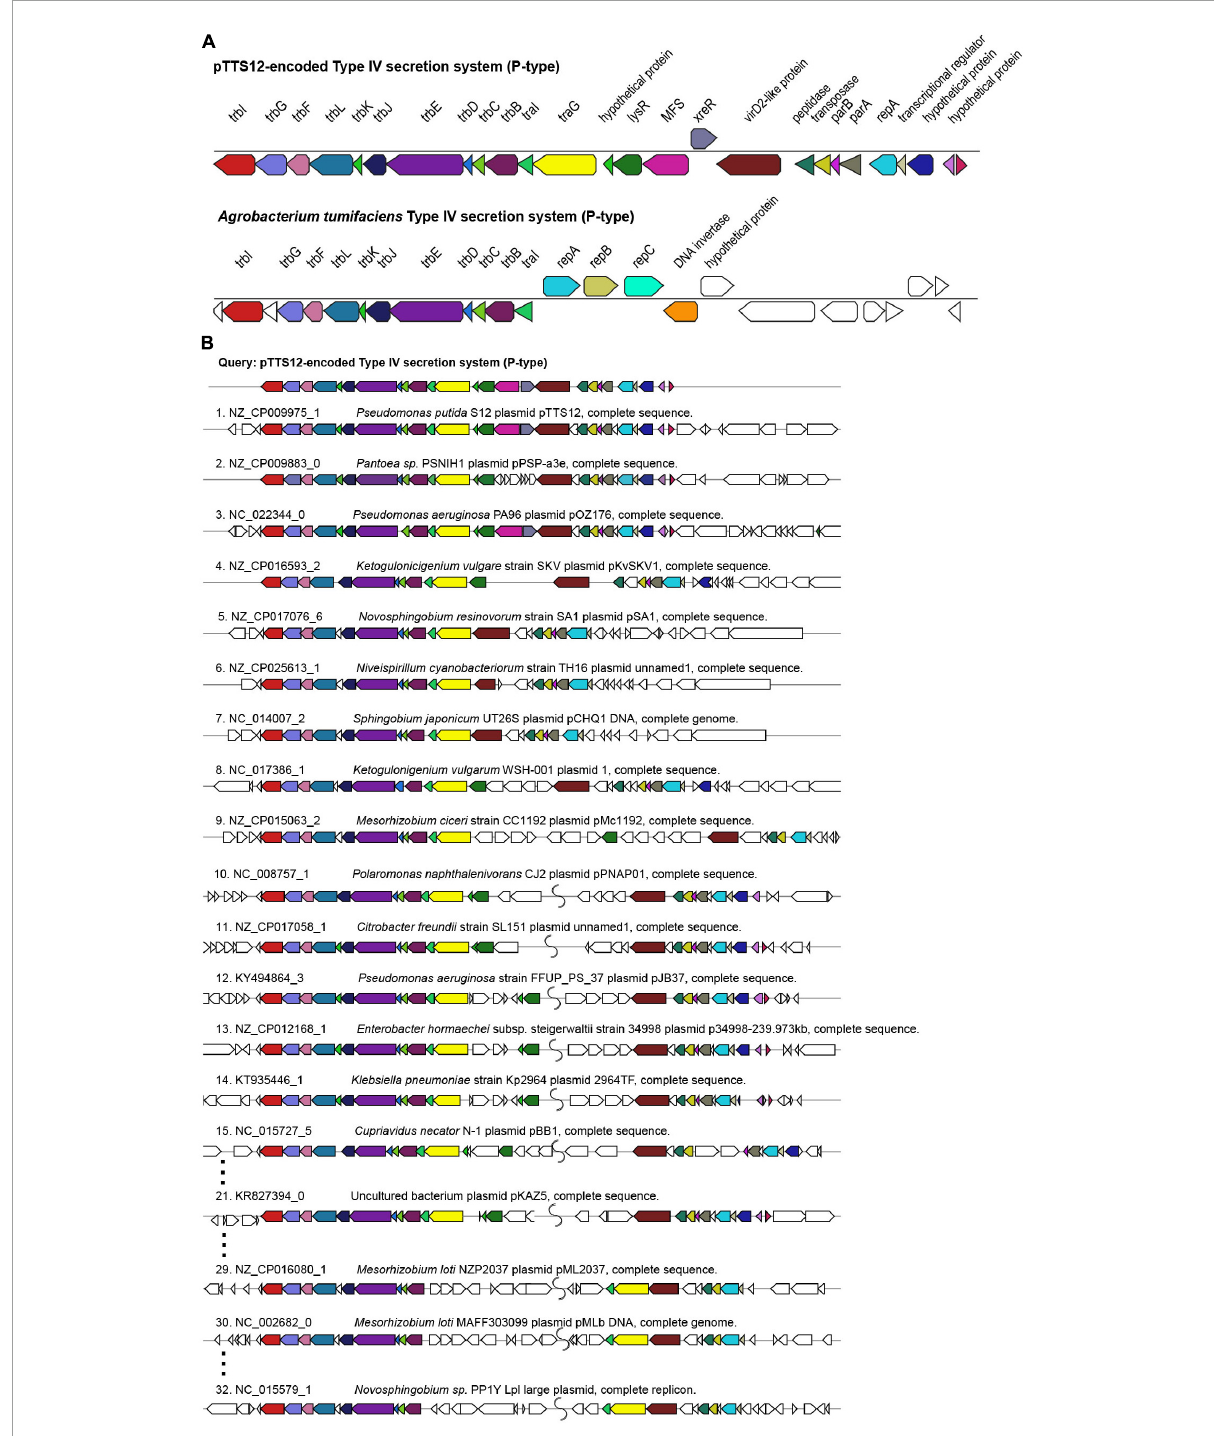
FIGURE2 Structure and synteny of pTTS12 conjugation system. (A) The arrangement of the T4SS gene cluster found in pTTS12 and the prototype trb operon from Agrobacterium tumefaciens (pTiC58). The colors represent different genes in the cluster and same colors are assigned for the homologous genes. The gene names are indicated above the respective clusters. pTTS12/T4SS and the trb operon of pTiC58 share synteny for 11 genes ( trbI to traI ), while other parts are clearly different. (B) Synteny plot of the T4SS gene cluster of pTTS12 for plasmid conjugation, replication and partitioning compared with other plasmids. This visualization was generated using multigeneblast software (Medema et al., 2013). The numbers refer to the order of decreasing synteny. For the sake of clarity, several plots were removed from this figure, indicated by the dots. The colors represent different genes in the cluster corresponding to color-coding in panel (A) . Putative coupling-protein (T4CP) traG is indicated in yellow and the putative relaxase virD2 -like protein is indicated in